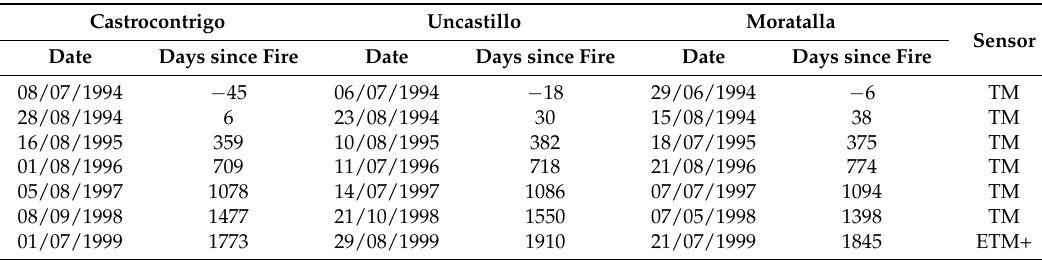
Table 2. List of images